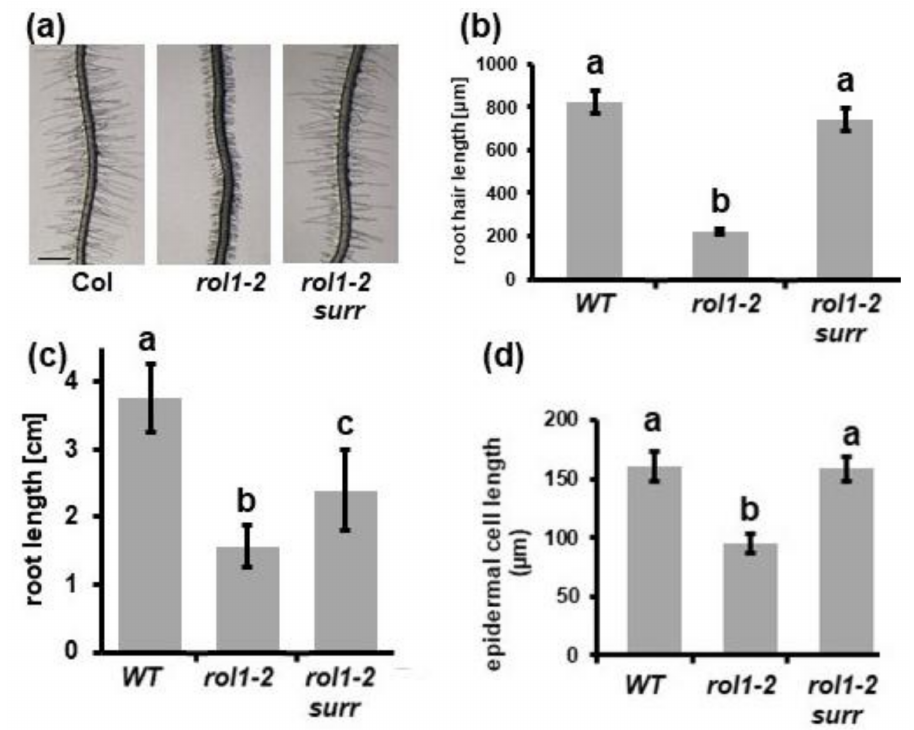
Figure 1. The reduced elongation of roots and root hairs of rol1-2 are suppressed by the surr mutation. Seedlings were grown for six days in a vertical orientation. ( a ) Wild-type Columbia (Col) seedlings developed roots with long root hairs, whereas the rol1-2 mutant developed shorter root hairs. This phenotype was suppressed in the rol1-2 surr mutant. ( b ) Quantification of root hair length of the different lines shown in panel ( a ). ( c ) A comparable effect was observed in the main root that is longer in wild-type Col than rol1-2 , while rol1-2 surr shows intermediate root growth. ( d ) Cell length of trichoblast epidermal cells is shorter in rol1-2, whereas Col and rol1-2 surr are not significantly different. The different letters above the columns indicate significant differences (student t -test, p < 0.05, n > 10). Error bars represent standard